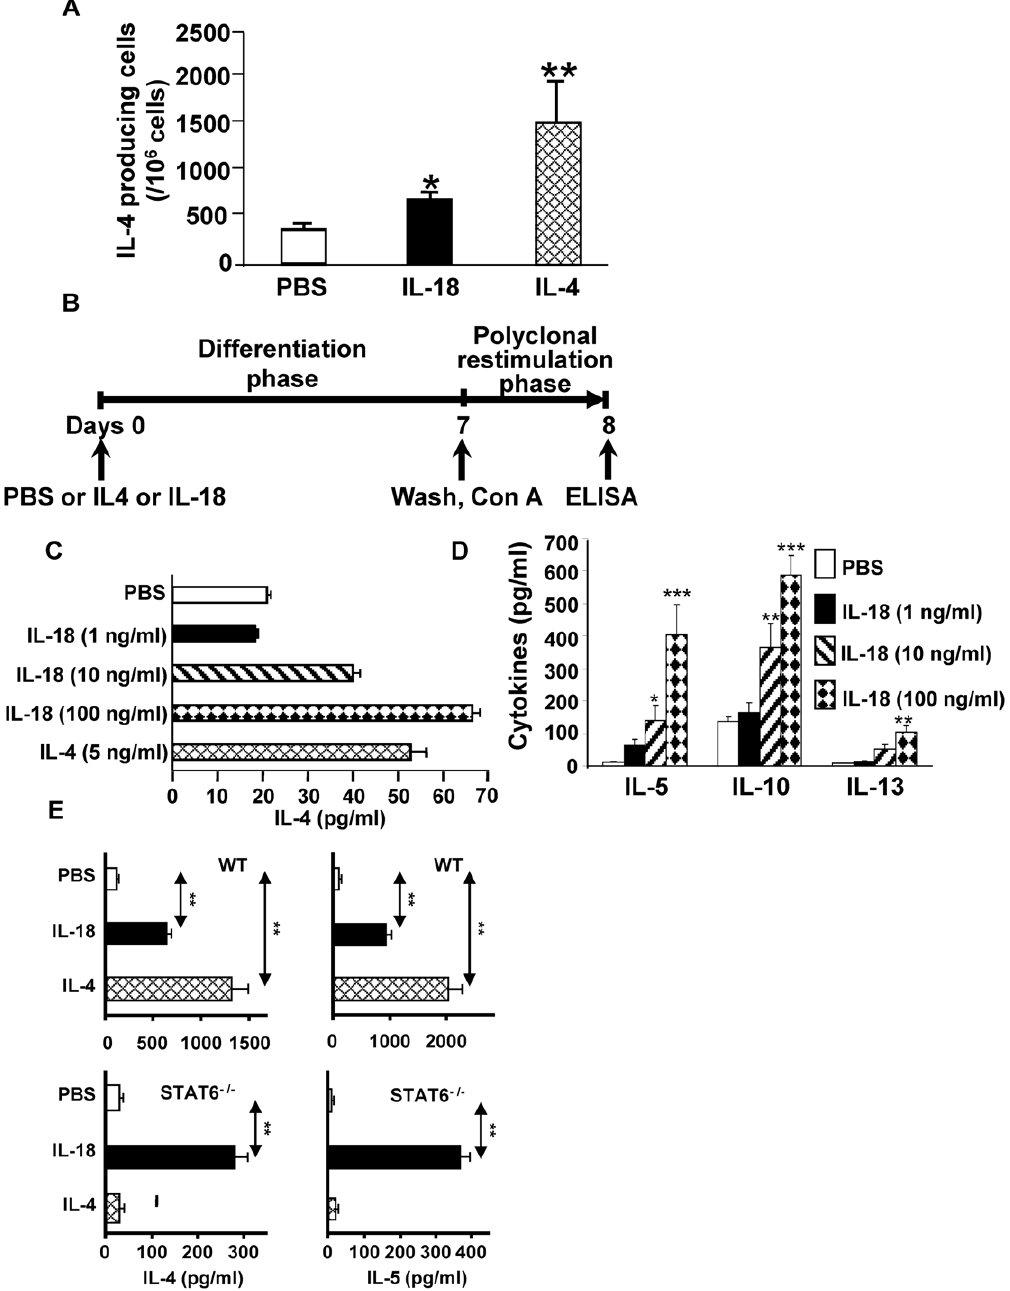
Figure 3. Effect of IL-18 on induction of Th2 differentiation. ( A ) Effect of IL-18 on IL-4 secreting splenocytes ELISPOTS. ( B ) T cell differentiation protocol used in Panels 3C–E and Fig. 4. ( C, D and E ) Effect of IL-18 or IL-4 on Th2 differentiation of naı¨ve CD4 + T-cells isolated from WT mice ( C ), IL- 4 2 / 2 mice ( D ) and WT and STAT6 2 / 2 mice ( E ). n=5 2 7 per group.